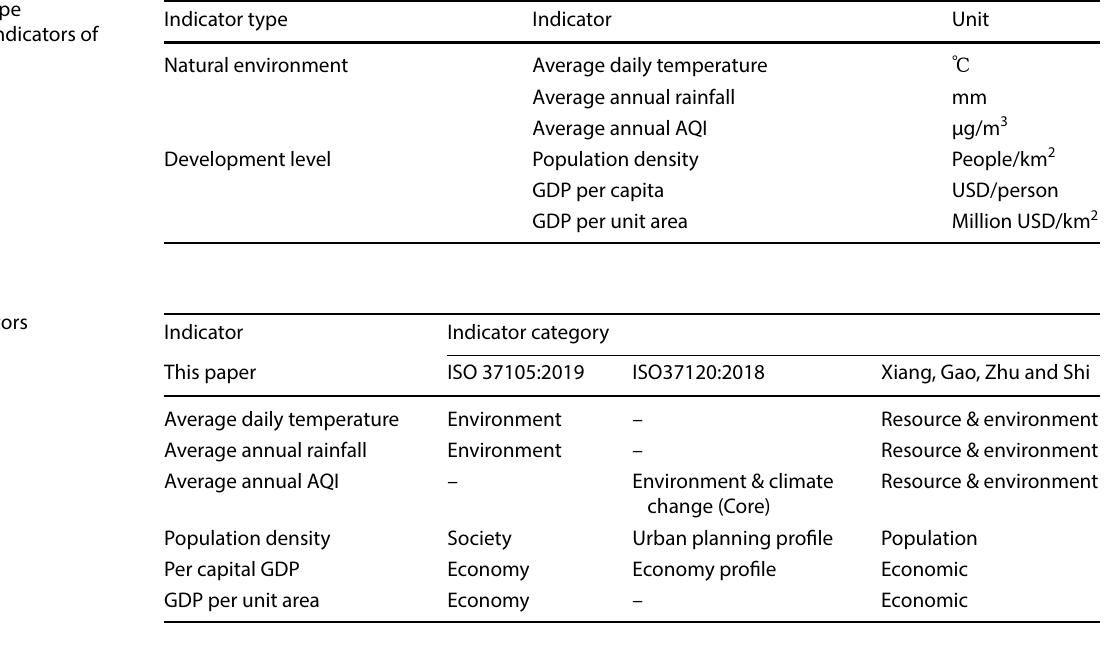
Table 3 City-type identification indicators of APEC cities